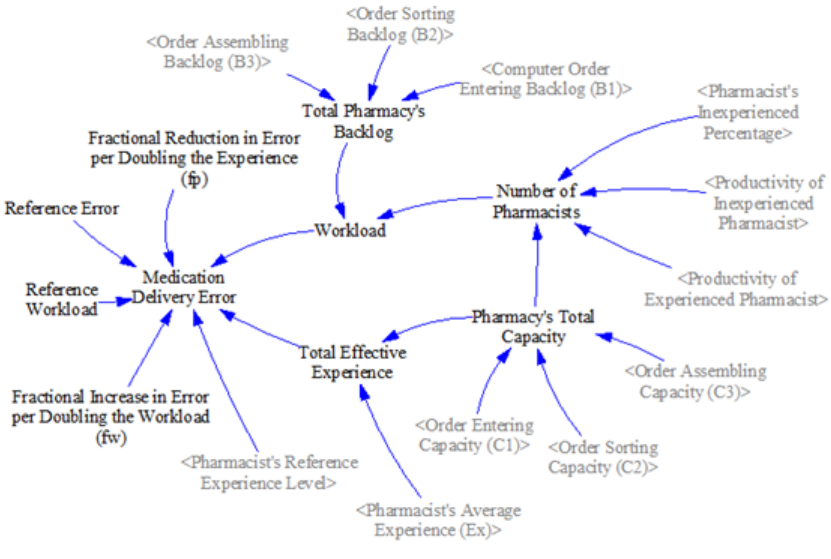
Figure 5. A Sub-model for medication delivery